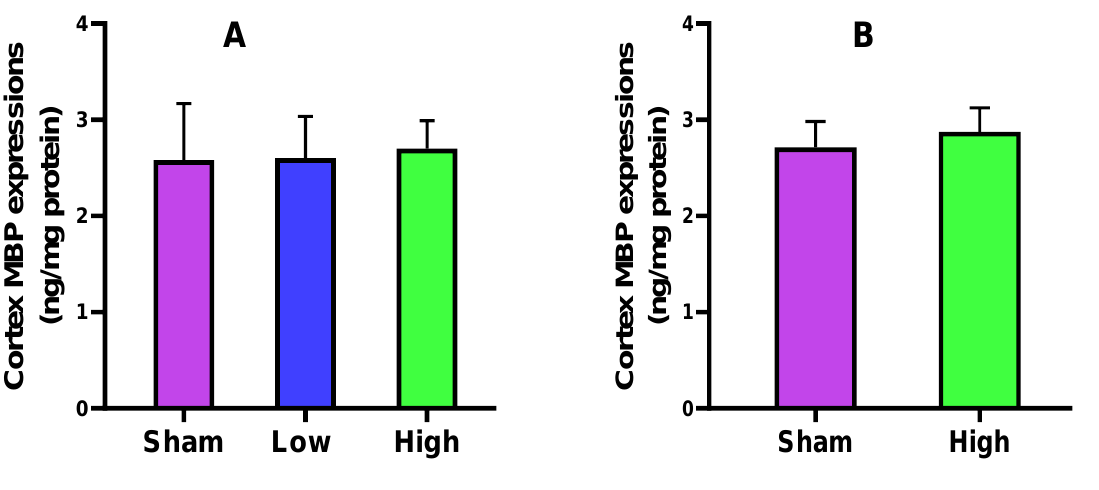
Figure 2. Effect of tDCS-iTBS on cortical MBP expressions (ng/mg protein): ( A ) short-term ( n = 15) and ( B ) long-term stimulations ( n = 16).